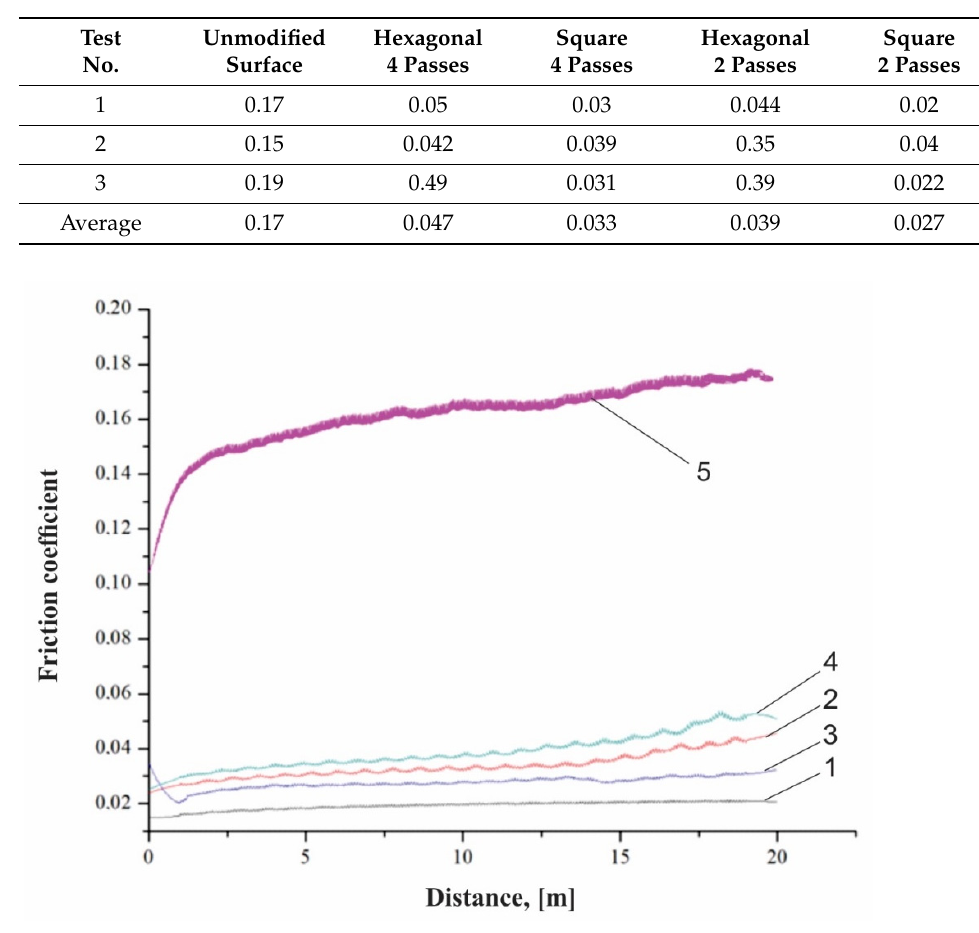
Figure 4. Friction coefficient diagram: 1-square 2x; 2-hexagonal 2x; 3-square 4x; 4-hexagonal 4x; 5-base material .